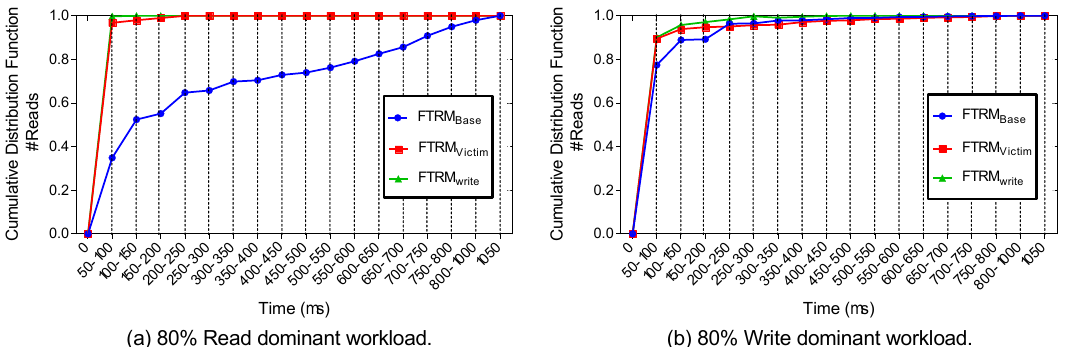
Figure 4. Comparison of Cumulative Distribution Function (CDF) for Mapping Reads I/Os between FTRM alternatives.